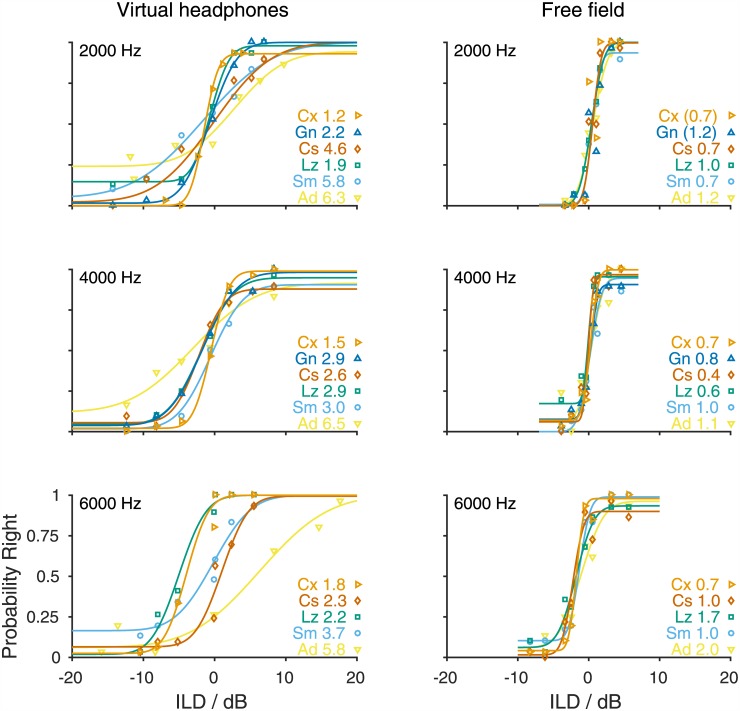
Probability of responses to the right as a function of ILD obtained with tones of 2000, 4000, and 6000 Hz.Symbols show individual performance of animals (2000 Hz: n = 6, 4000 Hz: n = 6, 6000 Hz: n = 5). Lines represent the cumulative normal distribution functions fitted to the raw data of individual animals. Identical colors and symbols represent data and fit of the same individual animal in the different panels. Thresholds (in dB) and identifiers of individual animals are given on the right.